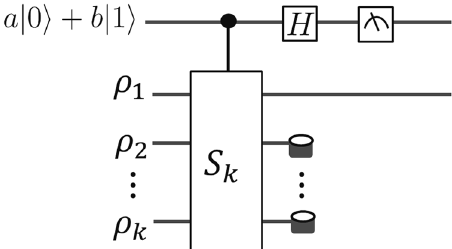
Fig. 2 The gadget to create ρ ′ ( r ) . Here S k is the permutation of k registers given in Eq. (32), and the waste bins indicate the partial trace. The H -gate is a single-qubit Hadamard gate and measurement is in the Z -basis. In ref. 41 they use the same circuit, but use the measurement outcomes to perform spectrum